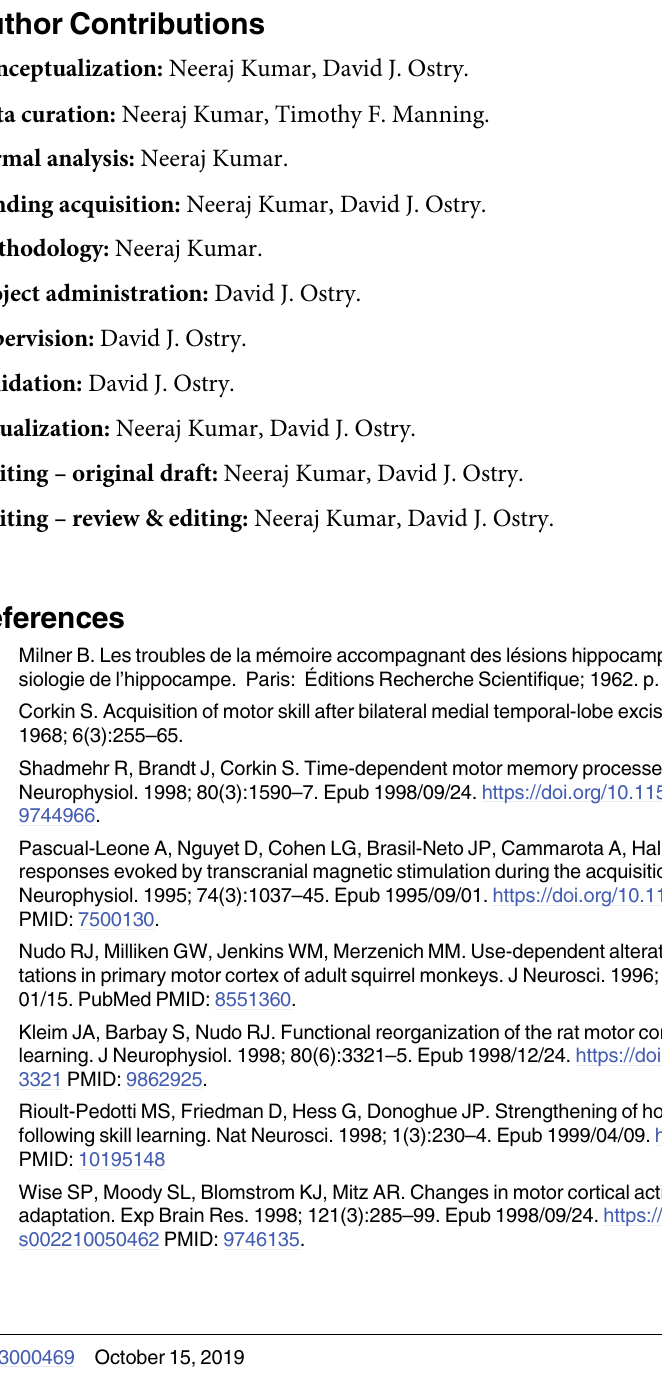
S3 Data. Raw data used to create summary plots in Fig 3. (XLSX) S4 Data. Raw data used to create summary plots in Fig 4.